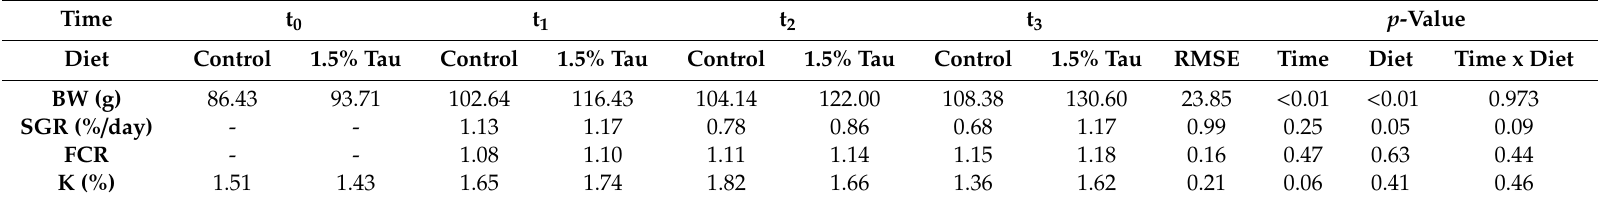
Table 2. Body weight, specific growth rate, feed conversion ratio, and condition factor values of European seabass fed with control or 1.5% Taurine supplementation diet. Time t 0 t 1 t 2 t 3 p -Value Diet Control 1.5%